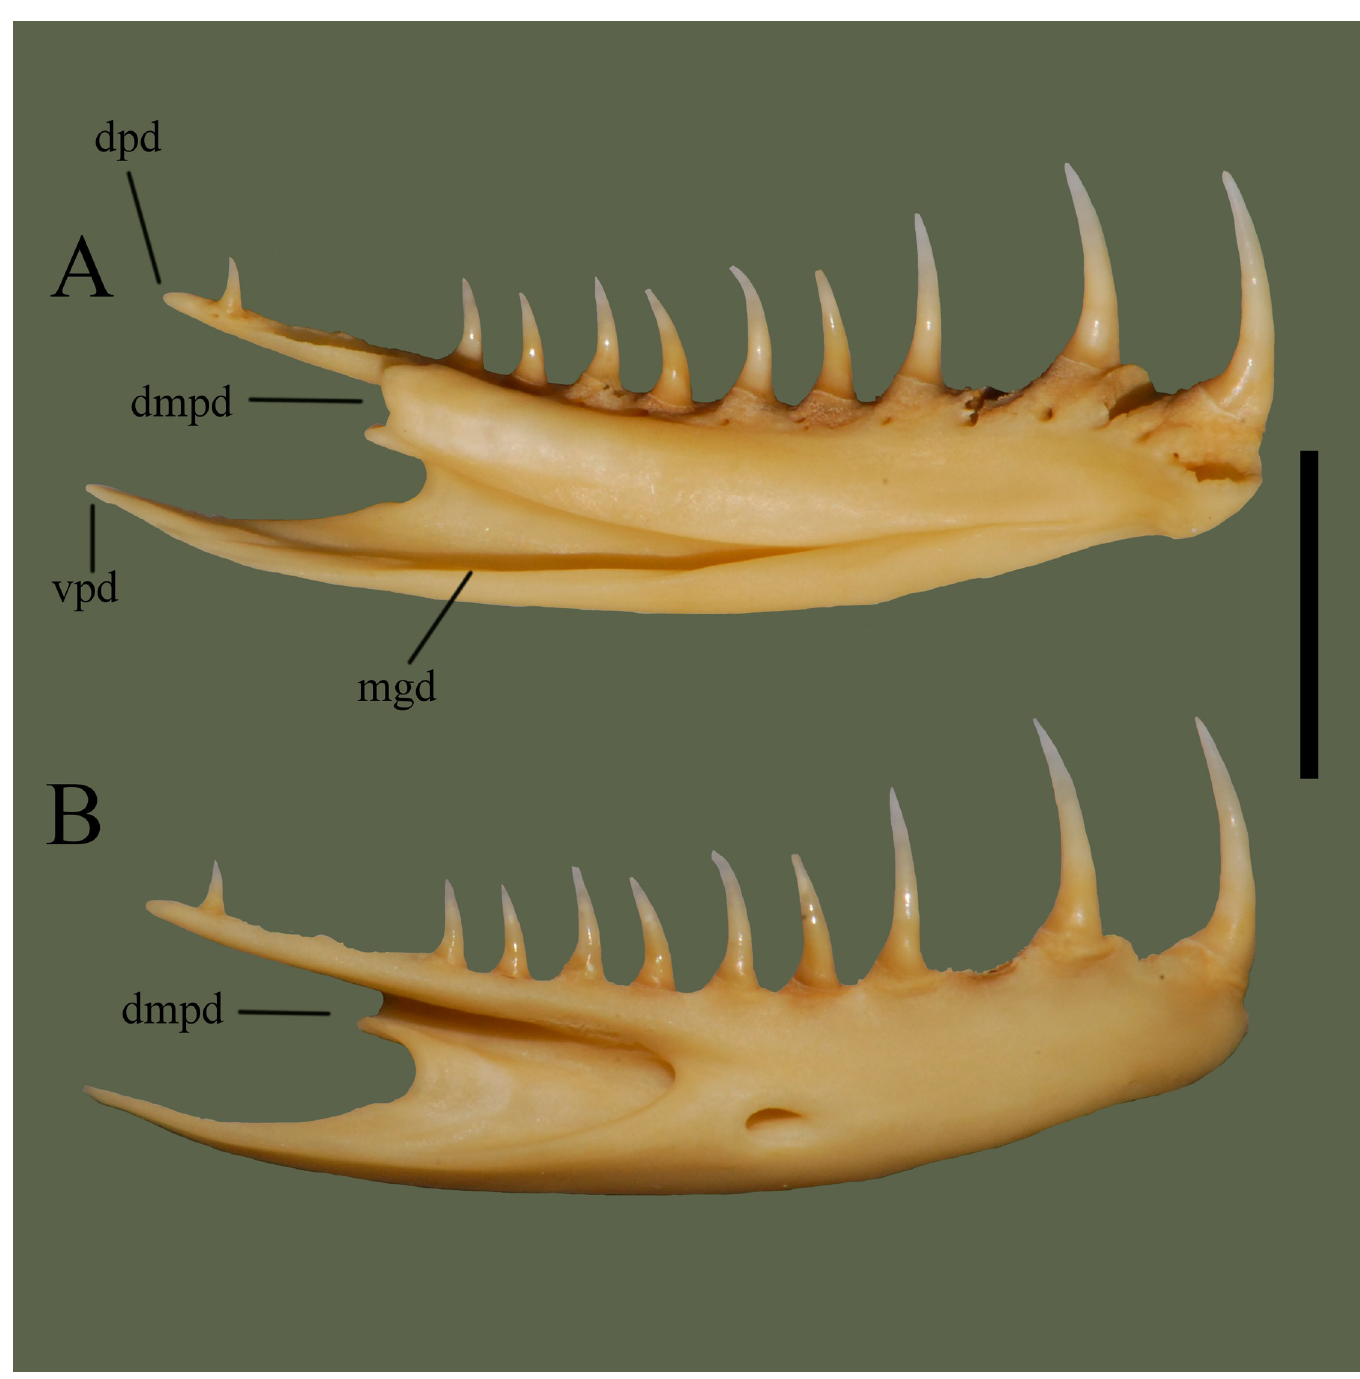
Fig 18. Right dentary (ETVP 3295) in medial (A) and lateral (B) view. Anterior is to the right. Scale bar = 5 mm. Abbreviations: dpd = dorsal process of dentary; dmpd = dorsomedial process of dentary; mgd = medial groove of dentary; vpd = ventral process of